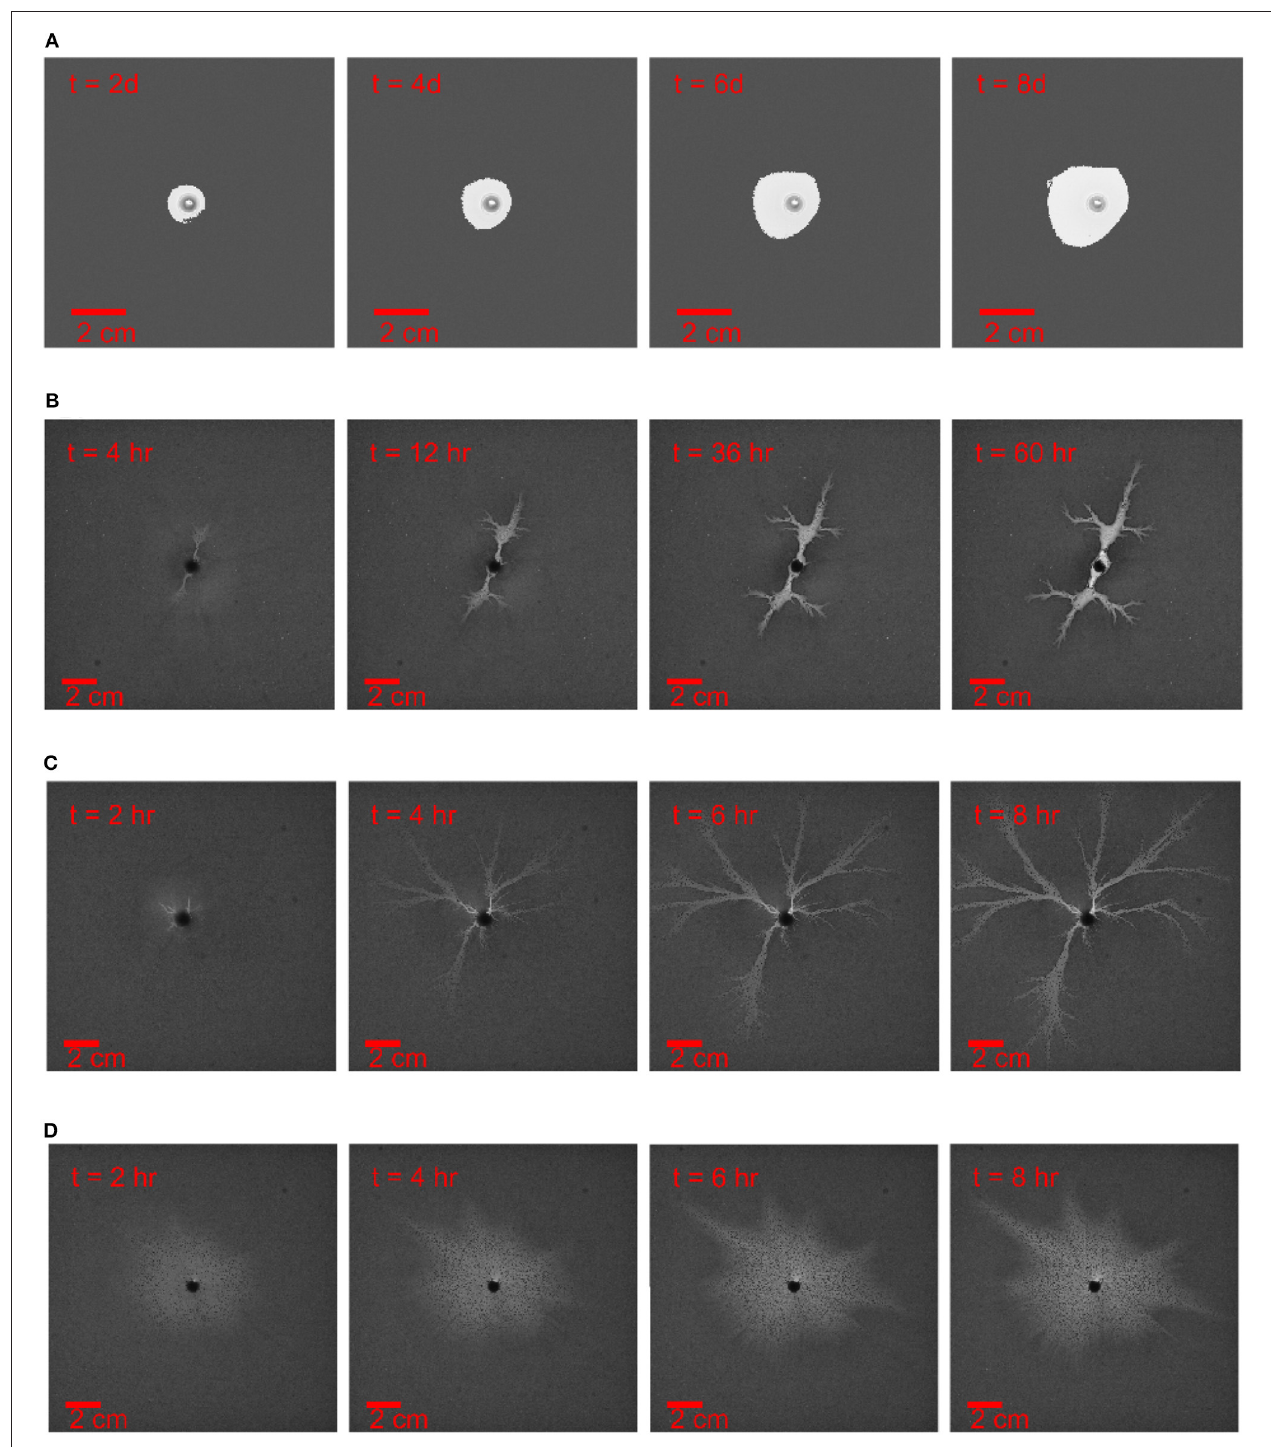
FIGURE 2 | Dissolution pattern evolution with time t, the aperture thickness is 50 µ m and the injection rate increases from top to bottom. The time and length scale are indicated in the images. (A) The injection rate is 0.6 ml / h , experiment I1 in Table 1 (B) The injection rate is 3 ml / h , experiment I2 in Table 1 . (C) The injection rate is 6 ml / h , experiment I3 in Table 1 . (D) The injection rate is 60 ml / h , experiment I4 in Table 1 Except for the case of the compact dissolution pattern (A) , the experiments are ended once there is breakthrough or the dominant channel is formed. The images are adjusted by contrast enhancement, otherwise the dissolution patterns are difficult to observe from the printed